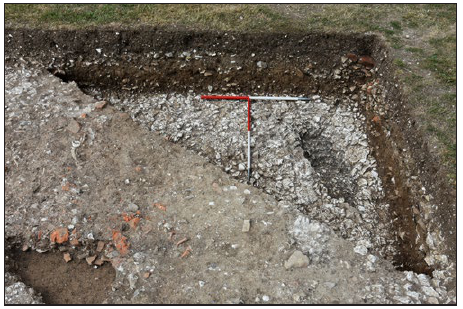
Figure 12: The NE corner of Trench 15, showing the Tudor rubble layer overlying the Roman ploughsoil (foreground and section). The base of an oval pit is visible, cut into the chalk. (Scales 0.5 m divisions). Photo: